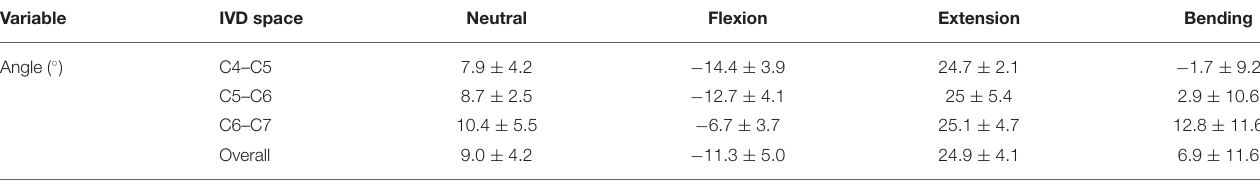
TABLE 5 | IVD wedge angles and motion extremes (means ± SD) of the segments C4–C5, C5–C6, and C6–C7 in cats. Variable Bending Angle ( ◦ )